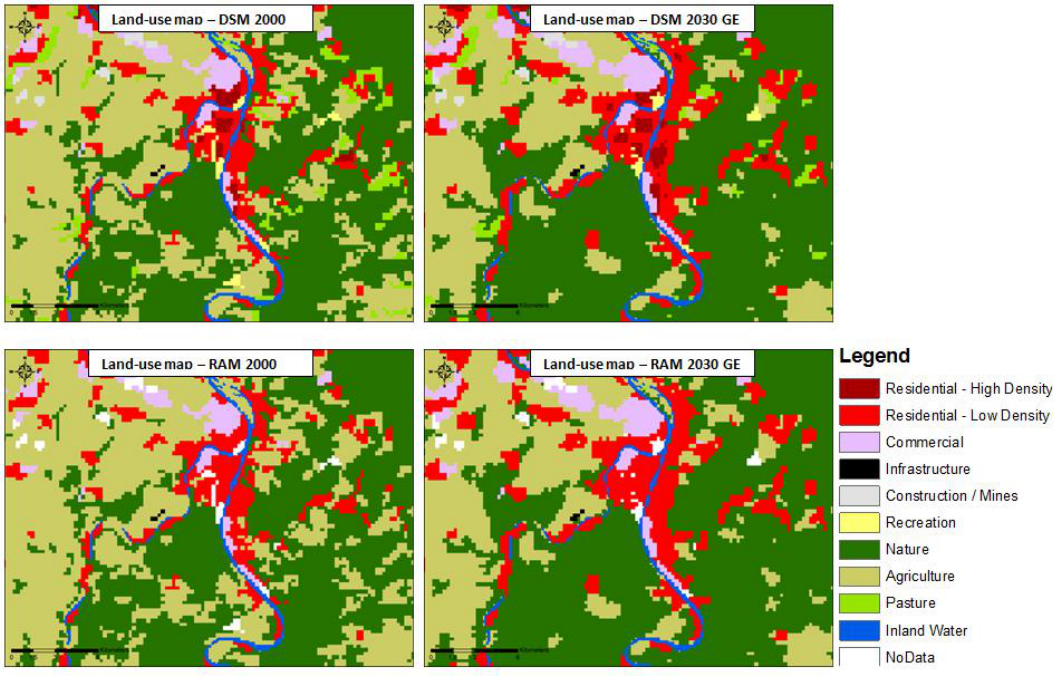
Fig. 2. Land use maps for 2000 and 2030 (GE scenario) used as input for the RAM and the DSM. 3